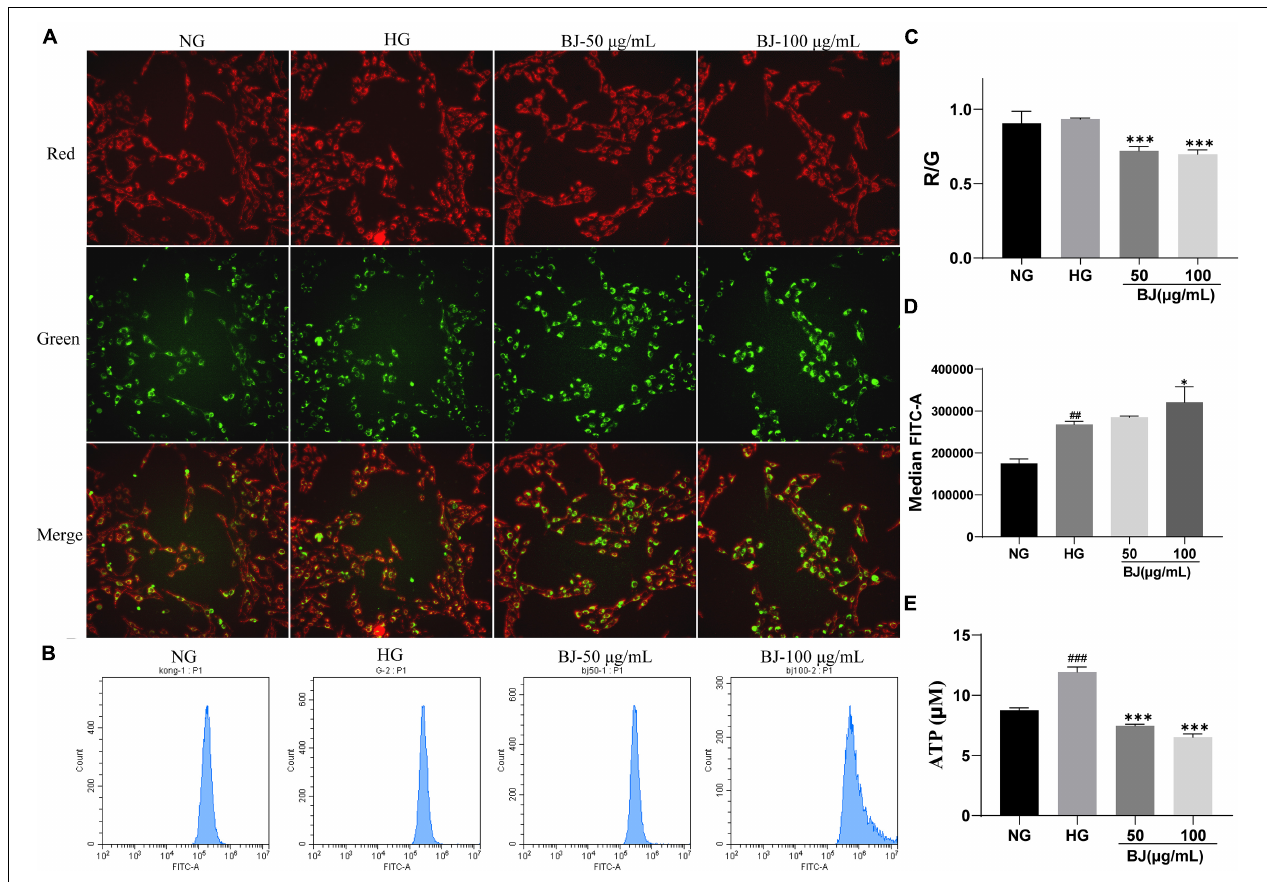
FIGURE 6 | Bie-Jia-Ruan-Mai-Tang (BJ) elicits mitochondrial dysfunction. (A) Representative images. JC-1 staining was used to evaluate the MMP change after treatment of the cells with BJ. The normal MMP shows red fluorescence, while green fluorescence represents the decreased membrane potential, indicating mitochondrial dysfunction. The ratio of red to green fluorescence was quantified (C) . The level of ROS in HRCECs was measured by a flow cytometer (B,D) . The ATP concentration was detected by the ATP assay kit (E) . Data are represented as mean ± SD ( n = 3). ## P < 0.01, ### P < 0.001 vs. NG; ∗ P < 0.05, ∗∗∗ P < 0.001 vs. HG.